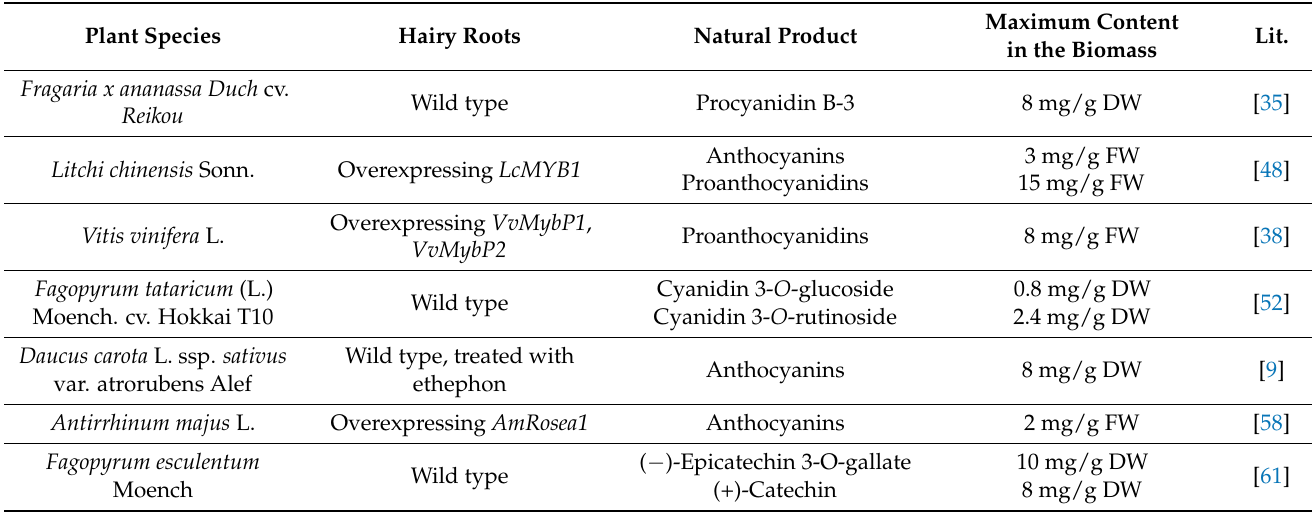
Table 1. Hairy root cultures that produced high yields of antioxidative natural